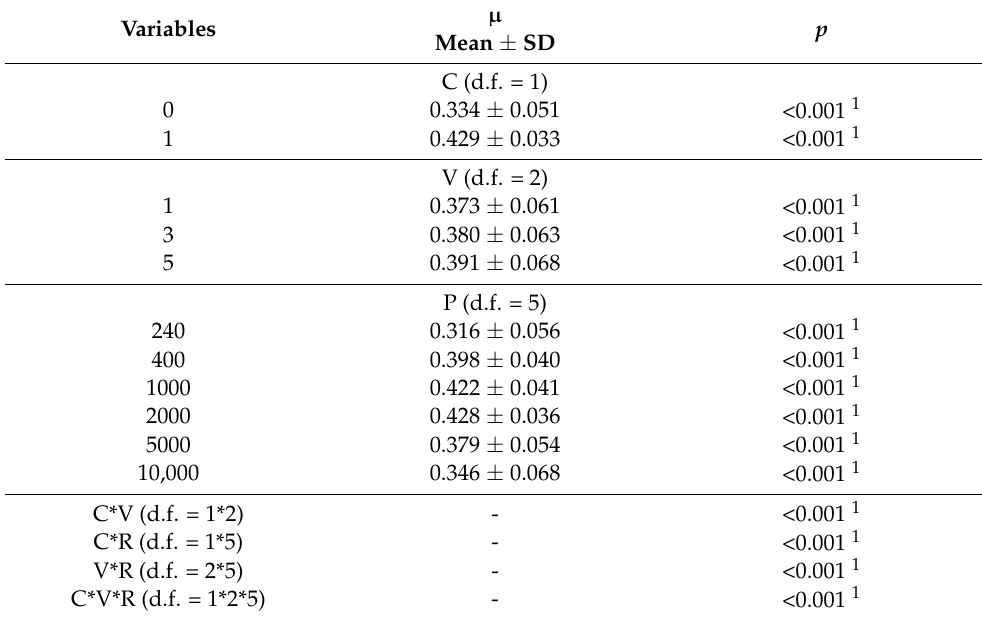
Table 3. The two-way ANOVA results of C (condition), V (speed), and R (roughness).